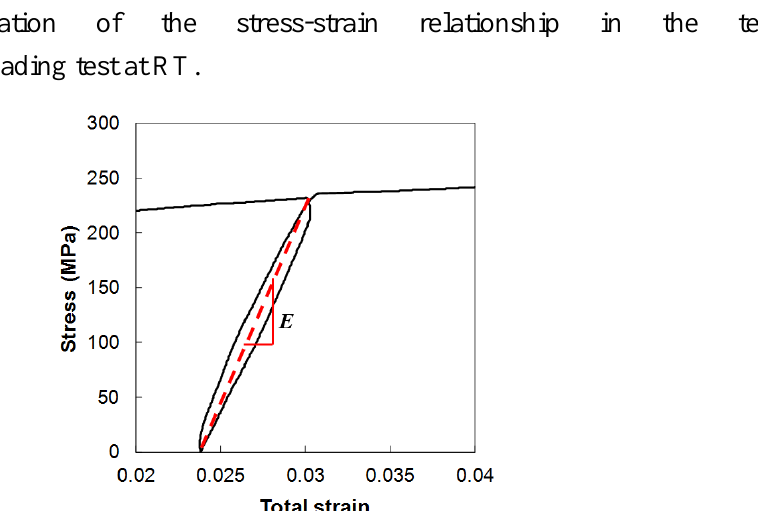
Illustration of the stress-strain relationship in the tension